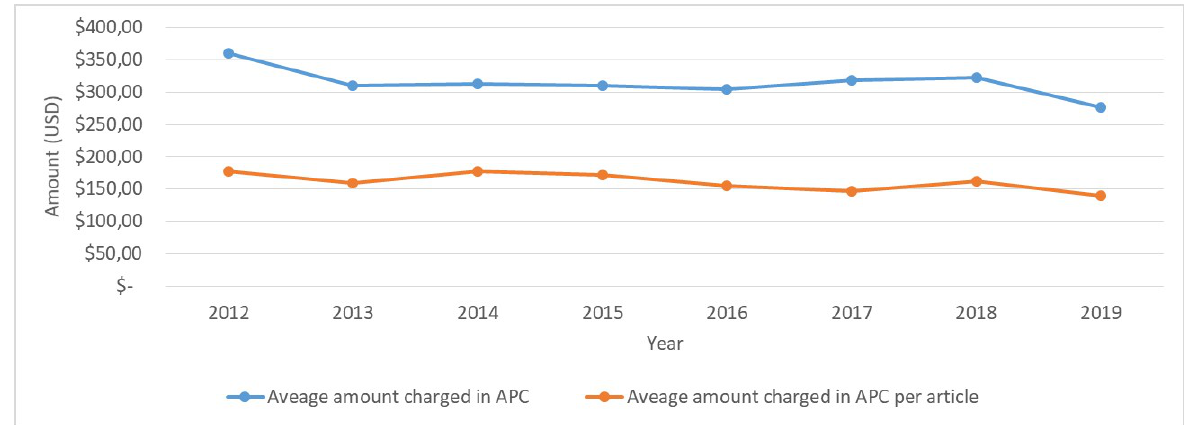
Figure 5. Average APC cost amount and average APC paid amount per article from journals maintained by non-profit entities in the 2012-2019 period. (Source: the